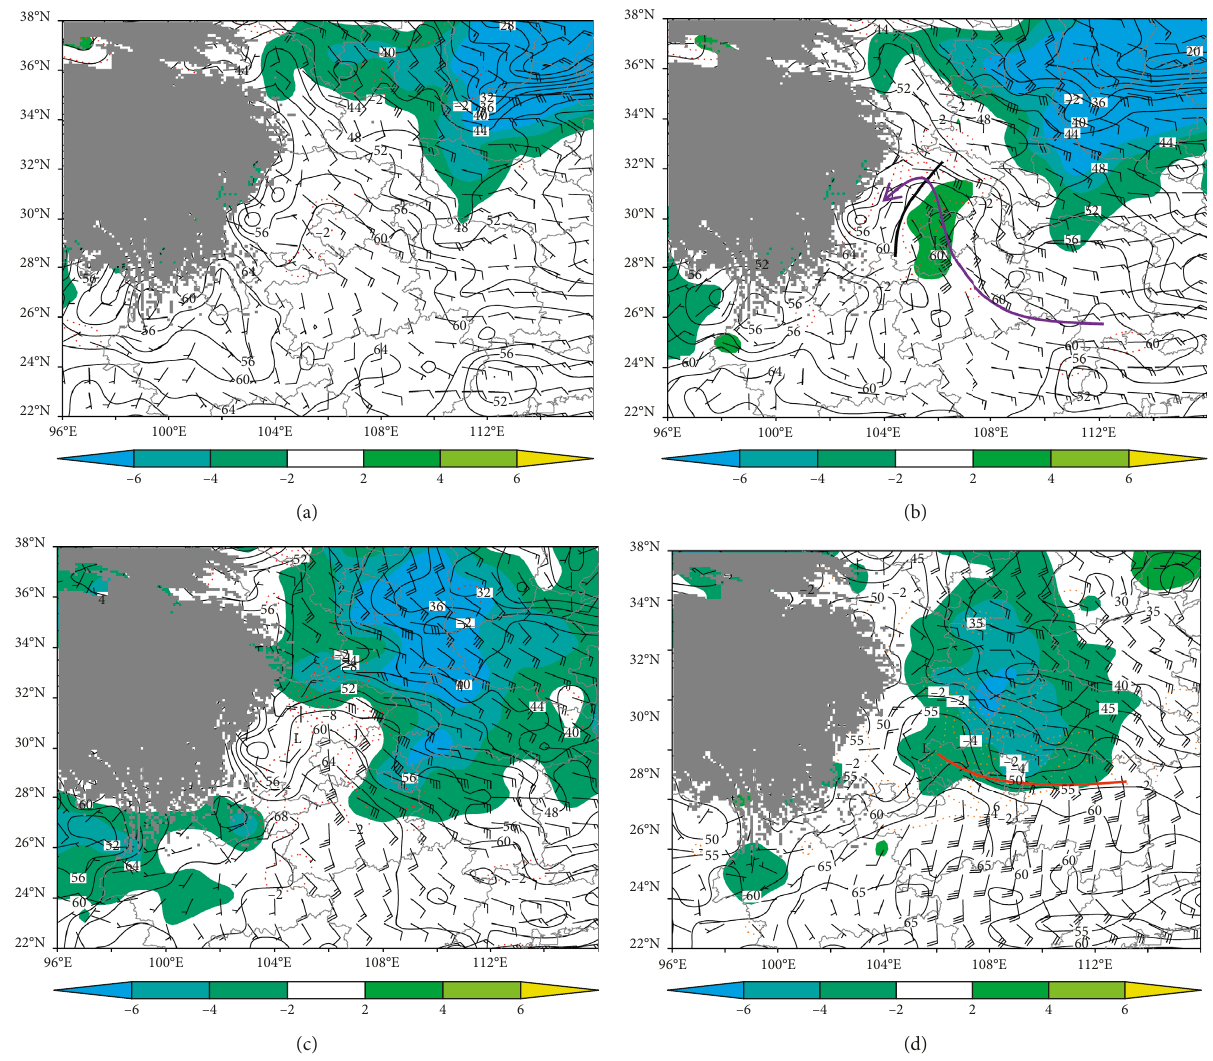
5 s 1 (color dashed line), 2 10 × − − −